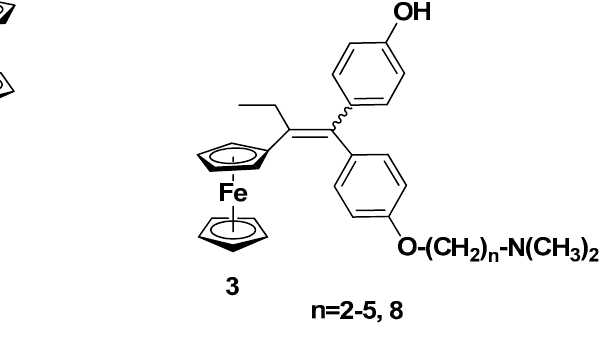
Figure 1. Ferroceron ( 1 ), ferroquine ( 2 ), ferrocifen ( 3